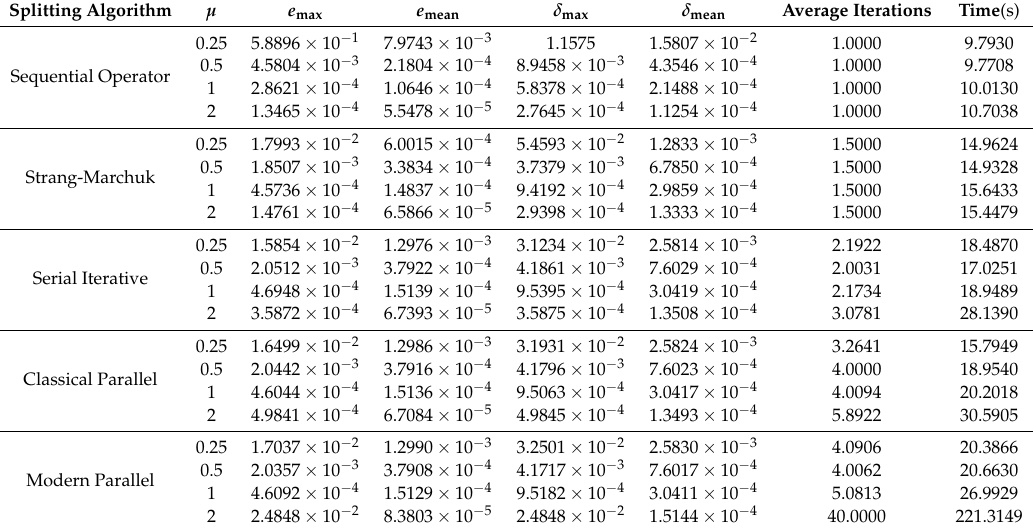
Table 10. Mixed convection-diffusion and Burgers’ equation. Results of the directional decomposition using the fourth order scheme for the spatial discretization, with 10 spatial subintervals, 640 temporal intervals and different values of µ .